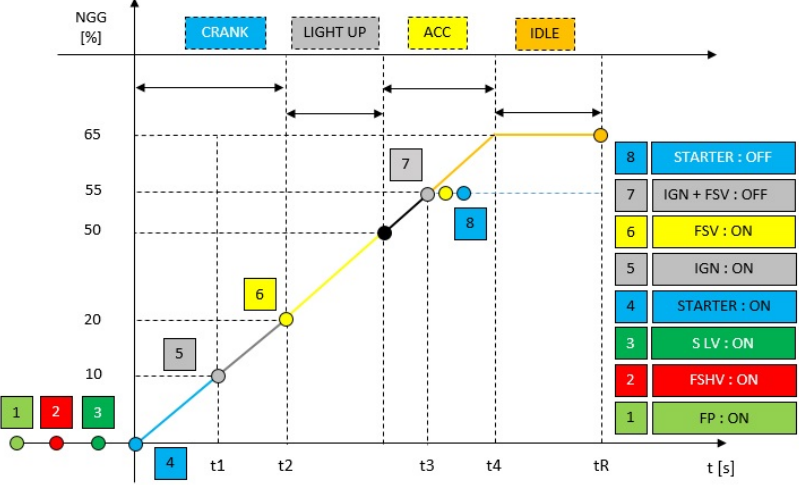
Figure 5. TV2-177A engine start-up diagram.